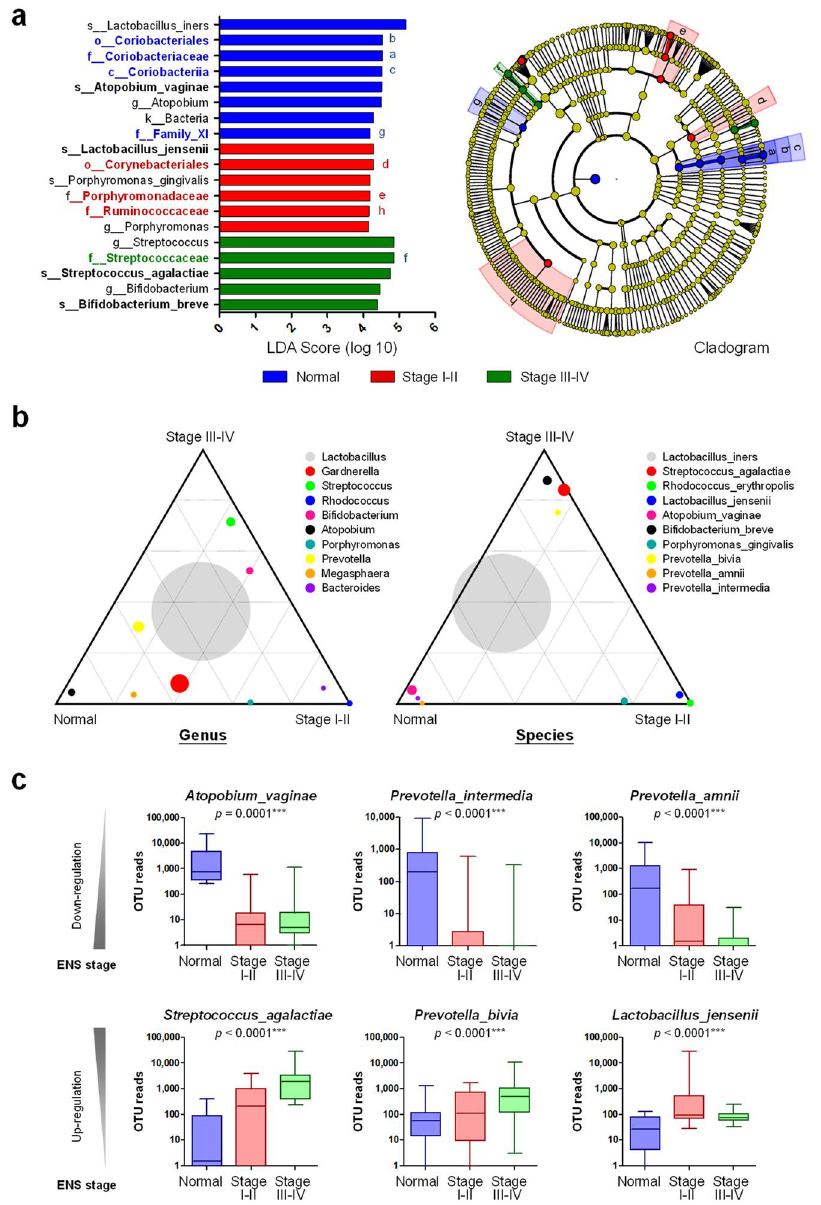
Figure 2. Microbial communities associated with endometriosis patients at different stages. ( a ) LEfSe (linear discriminant analysis (LDA) Effect Size) was performed to define microbial biomarkers for individual groups (normal women, patients at stage I-II, and stage III-IV) with statistical differences. The representative microbiotas for each group are shown with the LDA scores (left panel). The phylogenetic trees of dominant microorganisms are revealed in cladogram (right). ( b ) Ternary plots in Genus ( left ) and Species ( right ) taxonomic ranks were drawn based on relative abundance of top-10 OTUs among different groups. Circles represent dominant species and the size of those circles represent the relative abundance. ( c ) One-way ANOVA was performed to define the major mi- crobes down-regulated (upper) or up-regulated (lower) during endometriosis progression. Statistical significance: ***, p <